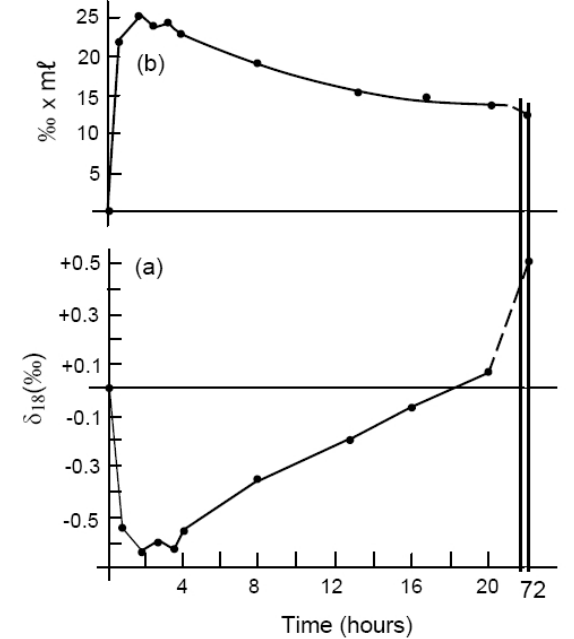
Fig. 11 The exit of isotopes accumulated in the membrane during the experiment il- lustrated in fig. 10 to the water in the upper cell: a Change of the δ above the membrane over time according to isotope balance calculation (in more exact terms this is difference between excess of exiting 16 O and 18 O isotopes). b Quantity of 16 O isotopes ( (cid:2) × ml) exiting from the membrane over time according to mass balance